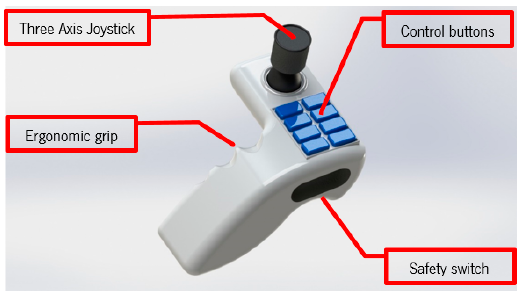
Figure 9. Ergonomic remote with three-axis joystick.